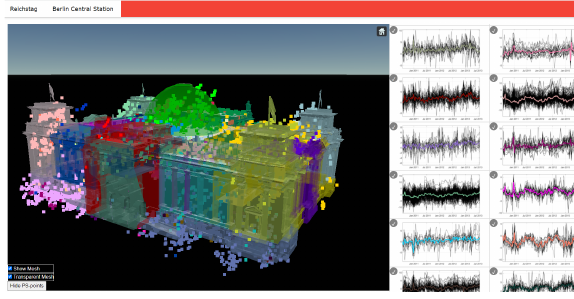
Figure 5. A web portal with the presented results. Left: Mesh superimposed with the PS-points. The clusters are color coded and correspond with the extracted time series on the right hand side. The user can move the mouse over a time series to highlight it in the 3d view, freely rotate and zoom and show/hide the mesh and the